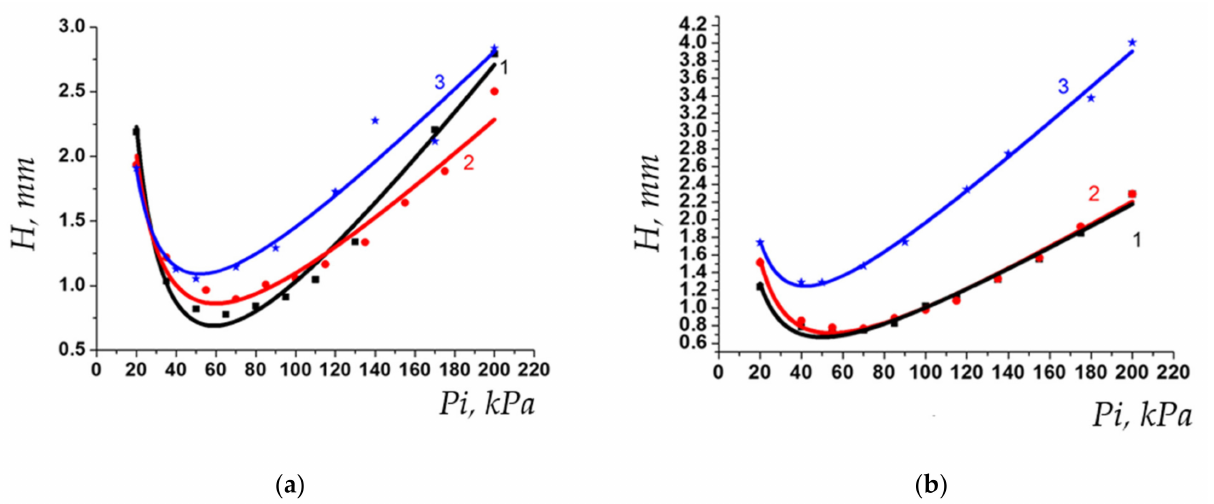
Figure 5. Changes in Van Deemter curve shape at accelerated thermal aging of PTBSN at 170 and 200 ◦ C for n -butane ( a ) and n -hexane ( b ); 1—native polymer, 2—aging at 170 ◦ C, 3—aging at 200 ◦